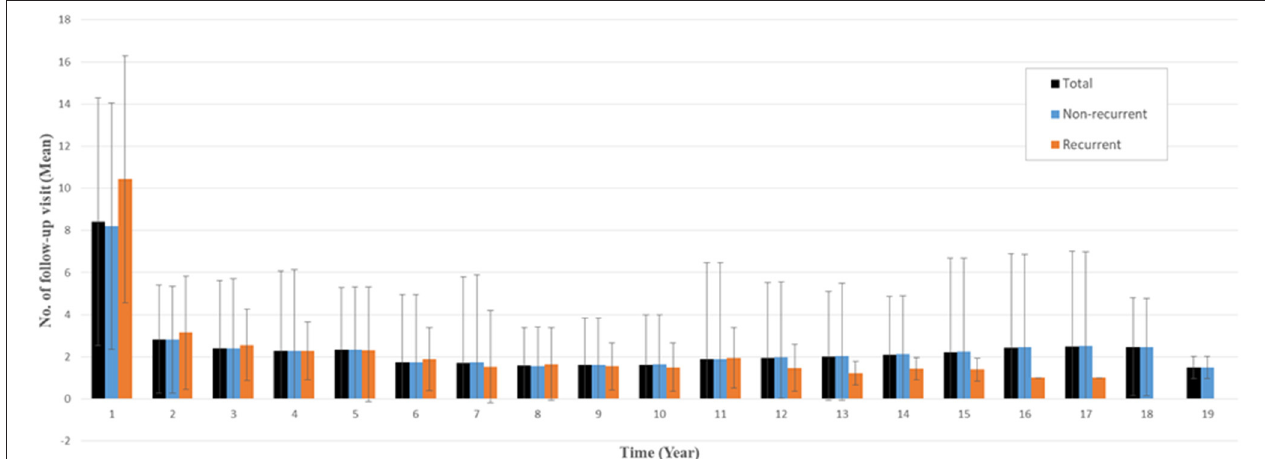
FIGURE 2 | Mean numbers of follow-up visits per year after surgery. Error bar indicates standard deviation.